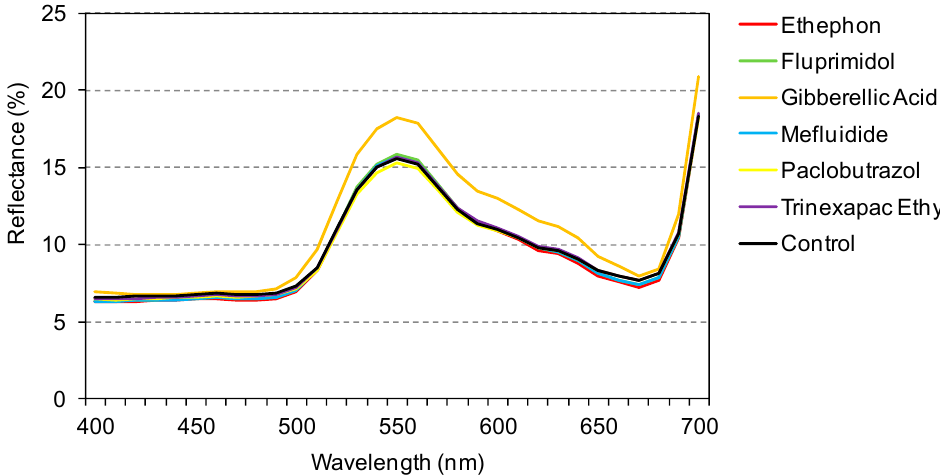
Figure 1. Reflectance of leaves after PGR application. Data are means of three tested cultivars of Kentucky bluegrass ( Poa pratensis L.).